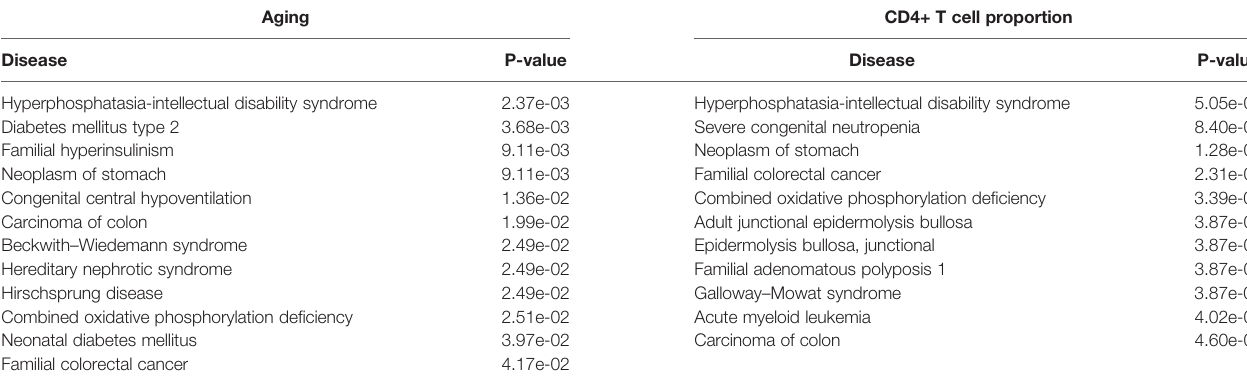
TABLE 4 | The signi fi cantly enriched ClinVar diseases of the aging- and CD4+ T cell proportion-derived differential genes.